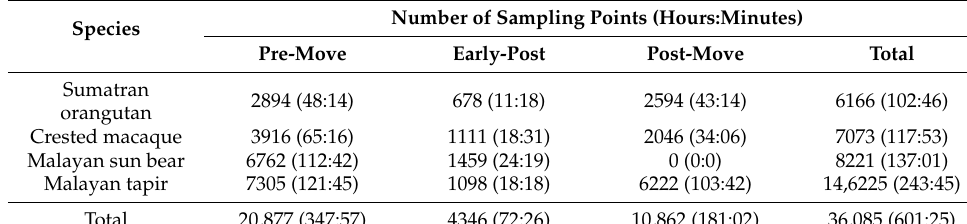
Table 3. Number of behavioural sampling points used for analysis by species and enclosure- move condition.